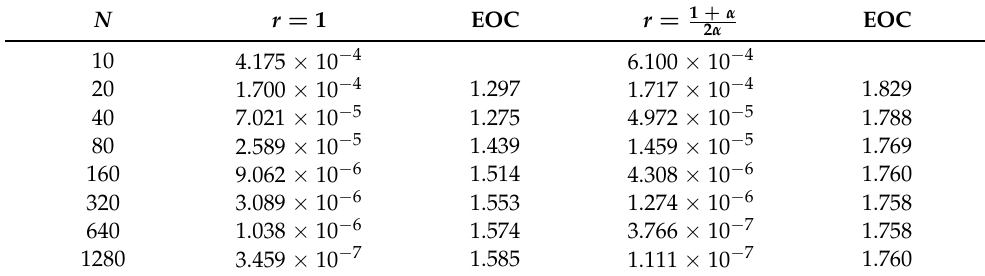
Table 7. Table showing the maximum absolute error and EOC for solving (27) using the predictor- corrector method for α =